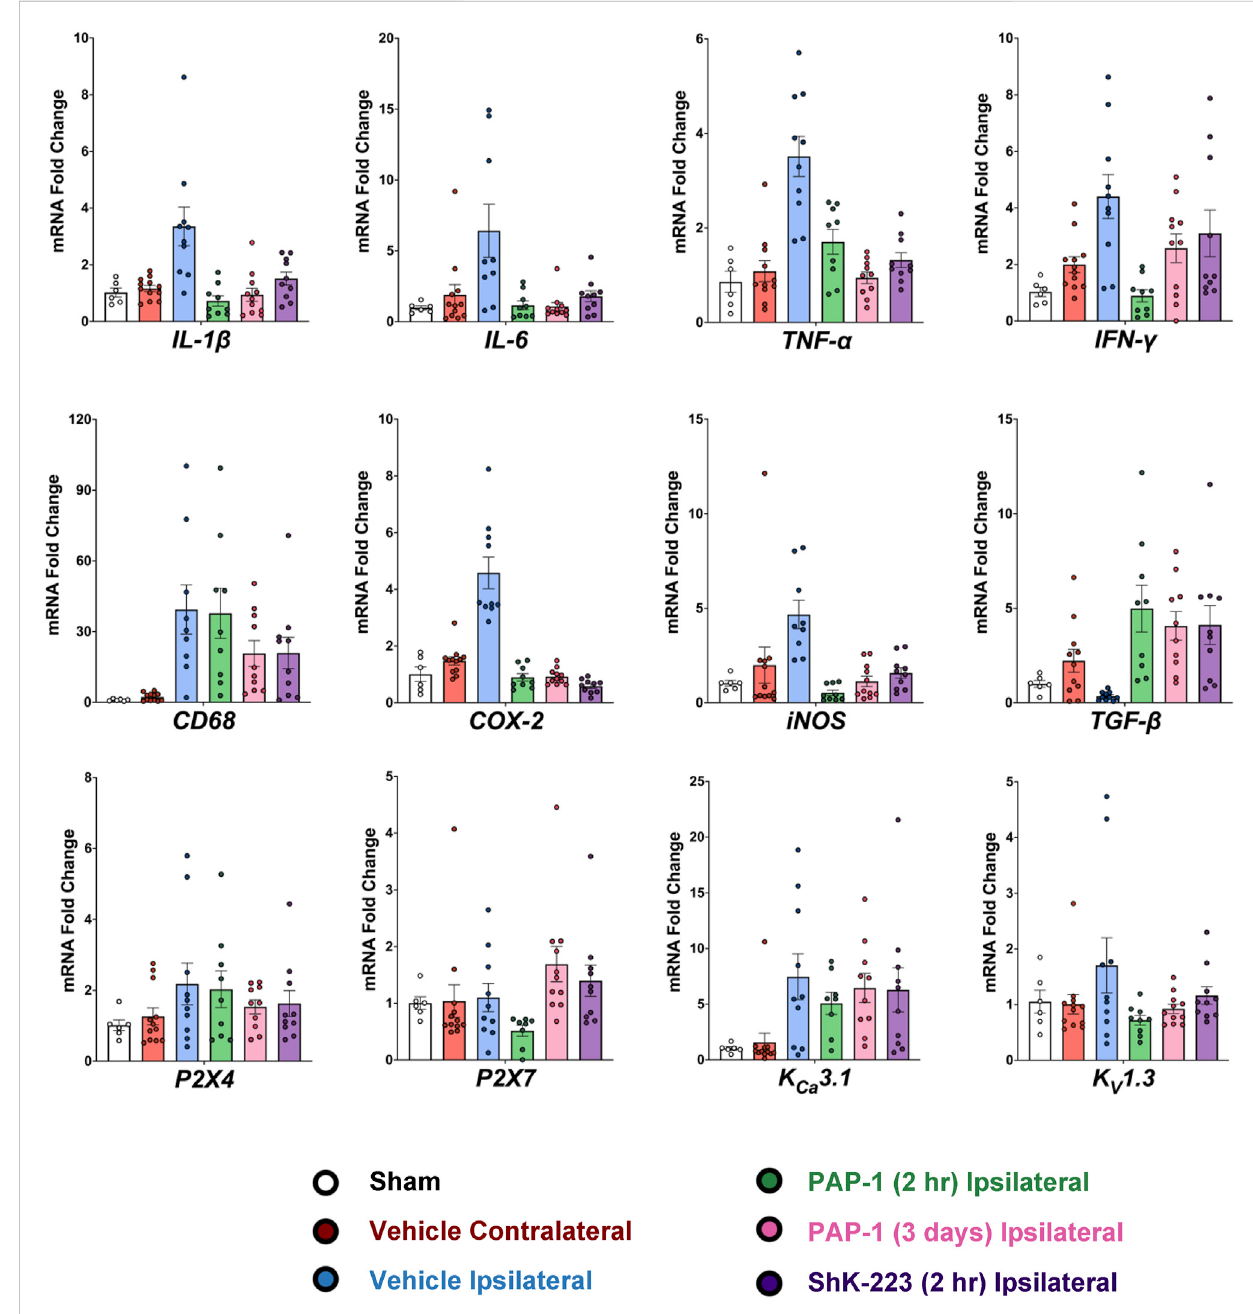
FIGURE 4 Blocking K V 1.3 with a brain-penetrant small molecule, PAP-1, and brain-impermeable peptide, ShK-223, both reduce pro-in fl ammatory cytokines in-vivo , as measured by RT-qPCR. mRNA expression levels are reported as a fold-change respective to the ipsilateral hemisphere of vehicle-treated MCAO mice. Values were normalized to sham rat brains and to the geometric mean of three housekeeping genes, β -actin , ywhaz , and hmbs . Data was analyzedwithone-wayANOVAfollowedbyDunnett ’ stestandareshownasmean±S.E.M;thewhiskersshowcon fi denceintervals.Forfullstatistics see Supplementary Table